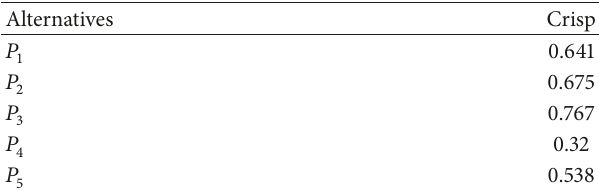
Table 4: The importance of criteria.